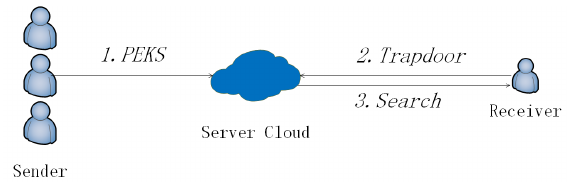
Figure 3. Public-key encryption with keyword search (PEKS) without a Private Cloud.